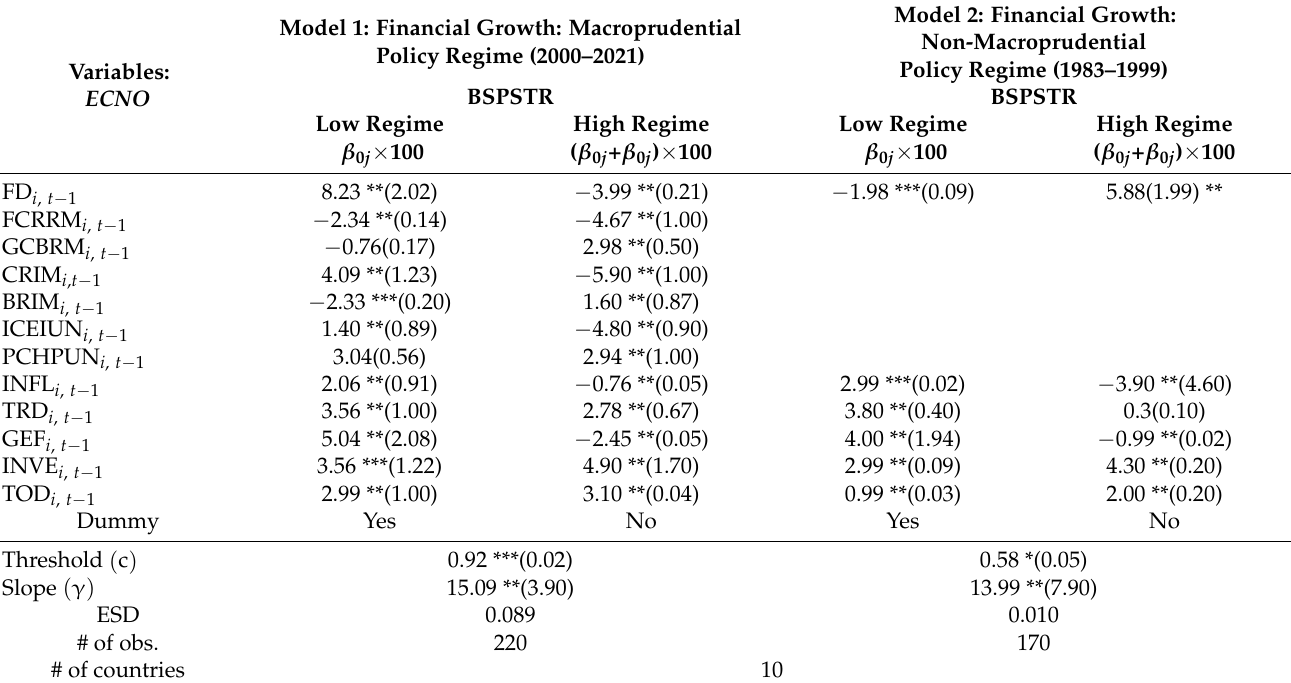
Table 3. Finance–growth relationship; BSPSTR, for African Emerging